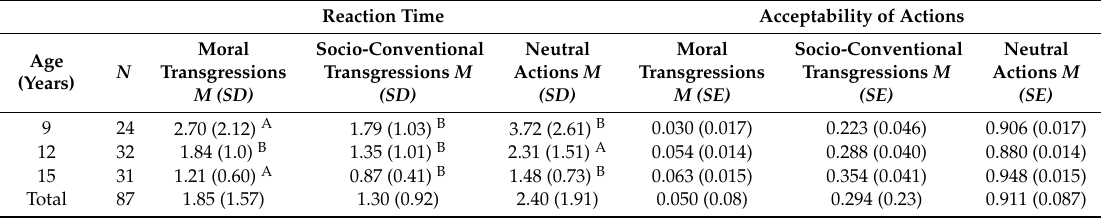
Table 1. Mean and standard deviations for reaction time and acceptability of transgressive / neutral actions.